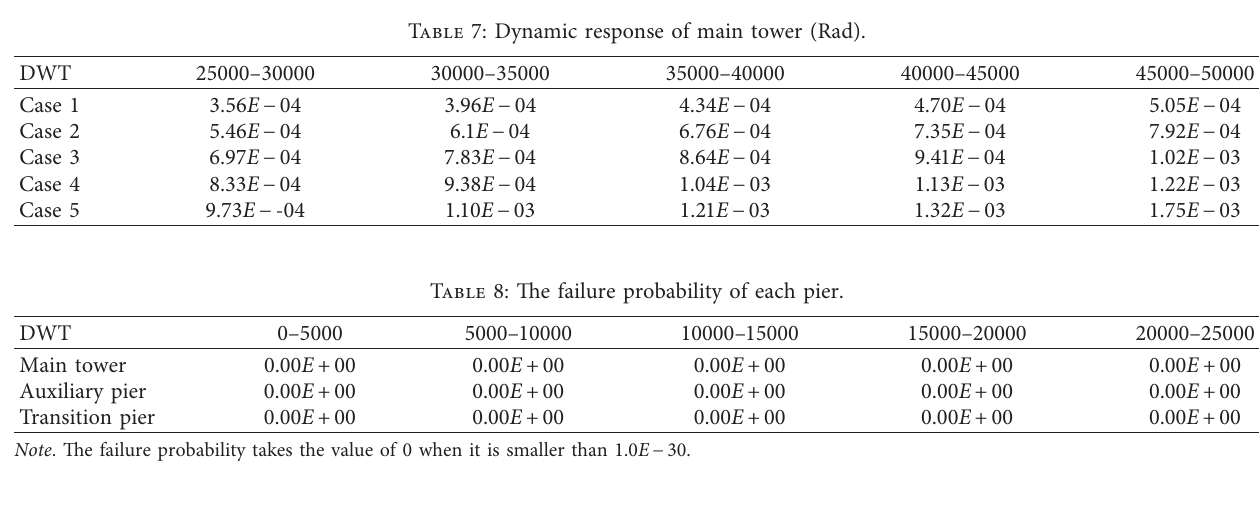
Table 9: The failure probability of each